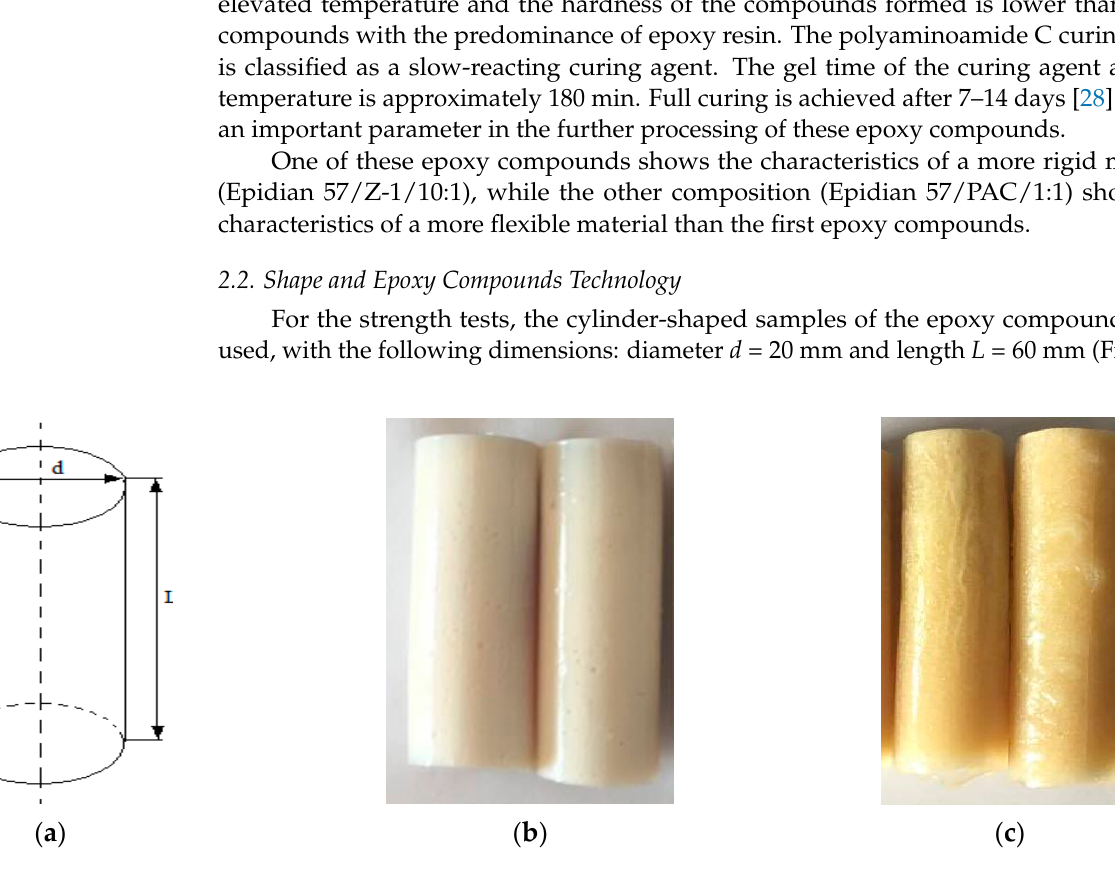
Figure 2. Epoxy compounds samples: ( a ) scheme; ( b ) Epidian 57/Z1/10:1, ( c ) Epidian 57/PAC/1:1. Proper preparation of the cylinder-shaped molds with dimensions d = 20 mm and L